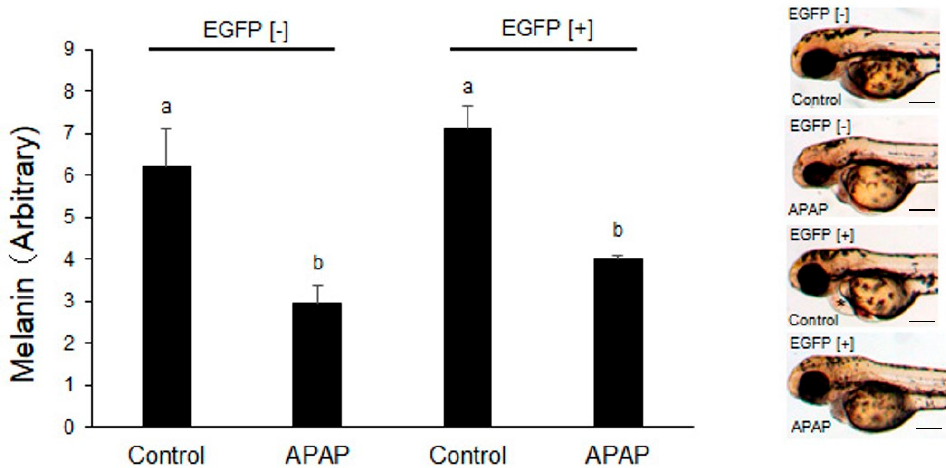
Figure 2. Effects of acetaminophen on melanin contents of rat CYP2E1-TG larvae. EGFP fluorescence-negative (EGFP [ − ]) and -positive (EGFP [+]) F2 CYP2E1-transgenic larvae were exposed to 2.5 mM acetaminophen (APAP) from 24 hpf to 54 hpf for determination of melanin contents. Control means no treatment since APAP was dissolved in ZR solution. Each tube contained 18–20 larvae, and the melanin contents of three tubes were determined for each treatment ( n = 3). Bars with different letters (a, b) are significantly different ( p < 0.05). Inset images in the right are also shown. Asterisk indicates mild pericardial edema in inset image.